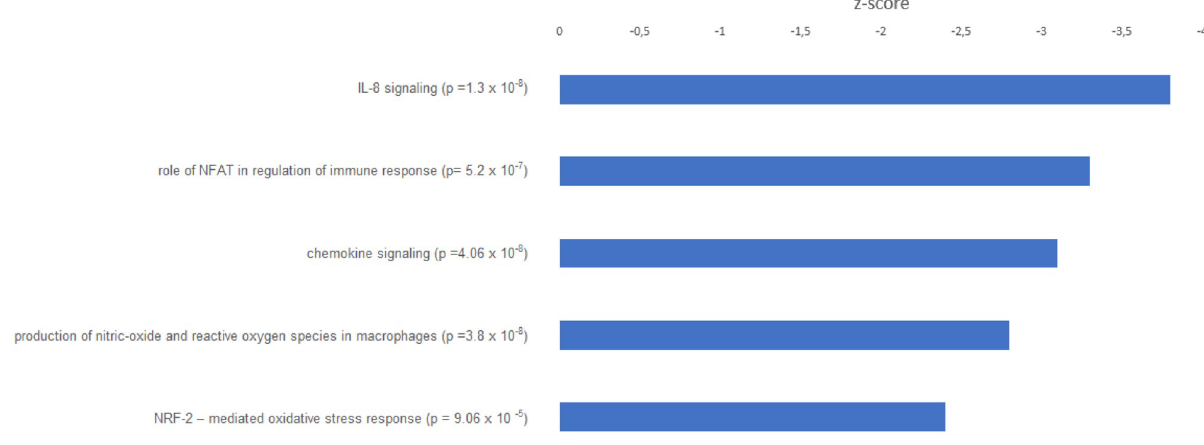
Fig 1. Top 5 over-expressed pathways in non-PG endometrial samples.